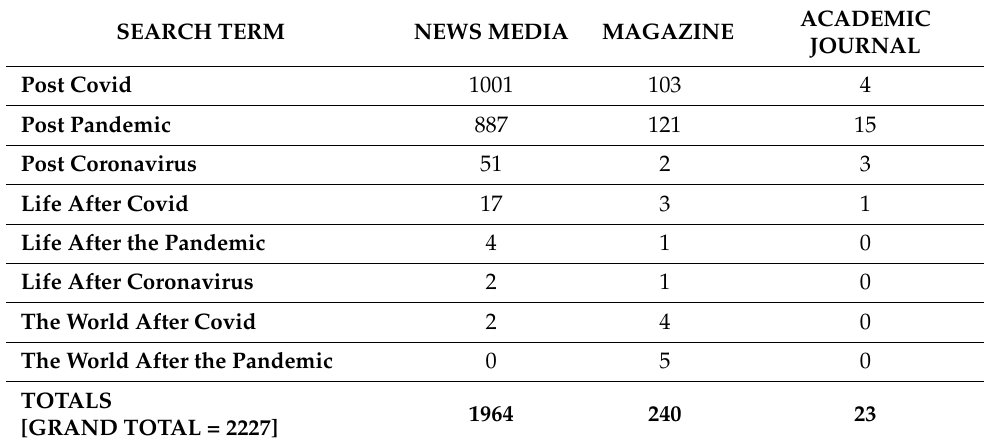
Table 1. Canadian Periodicals Index Keyword Search (29 February 2020–31 July